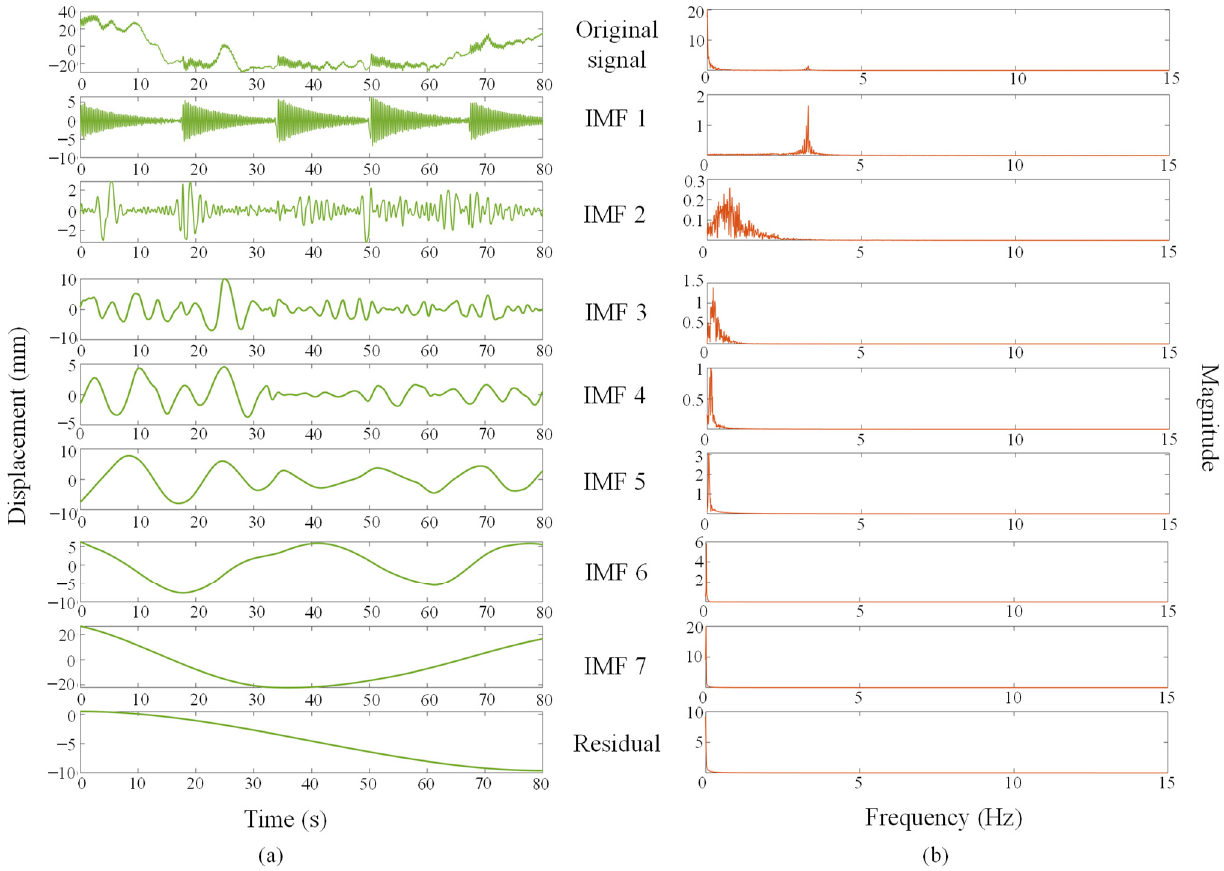
Figure 12. The results of EMD: ( a ) components of the original signal; ( b ) spectrum diagrams of the components.